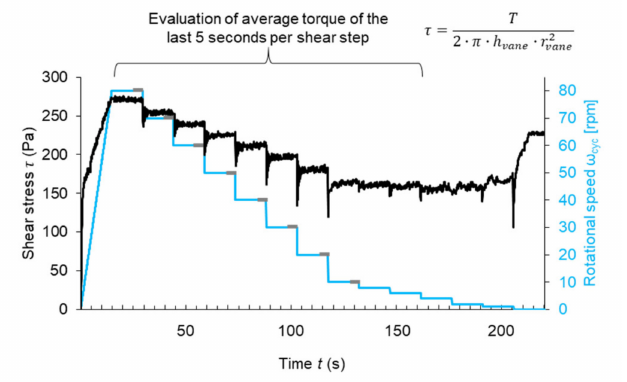
Figure 2. Shear protocol in the rheometer and exemplified shear stress measurement of ST0.0_SP